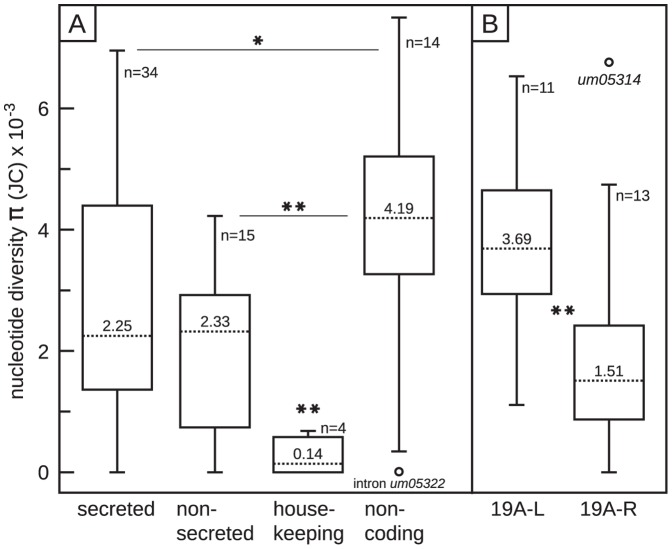
Boxplot comparisons of nucleotide diversity π datasets.(A) Nucleotide diversity boxplot diagrams of putatively secreted and non-secreted protein-coding as well as house-keeping genes (ef1-α, rpb1, gapdh and ITS including 5.8S rDNA) and non-coding regions. (B) Nucleotide diversity boxplot diagrams of sub-datasets of cluster 19A. 19A-L: left part of cluster 19A genes encoding secreted proteins (um05294 – um10555); 19A-R right part of cluster 19A genes encoding secreted proteins (um05305 – um05319); Dotted line: median; n: number of sequences per dataset. *: p≤0.05; **: p≤0.01 in Student's t-test.